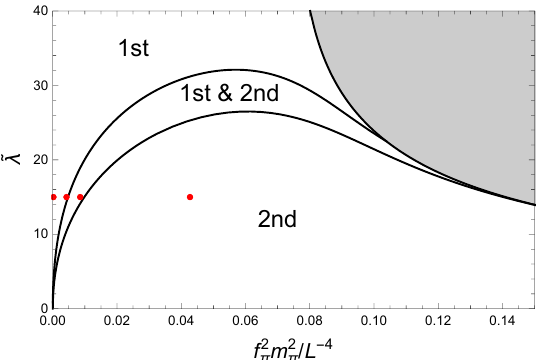
Figure 7 . Di(cid:11)erent topologies of the phase diagrams in the plane of rescaled ’t Hooft coupling ~ (cid:21) and quark mass parameter, classi(cid:12)ed according to the mesonic-LTQ transition, which can be discontinuous everywhere ("1st"), discontinuous at small temperatures and continuous at large temperatures ("1st & 2nd") or continuous everywhere ("2nd"). The shaded area is excluded since our approximation breaks down. The 4 (red) dots mark the parameter pairs chosen for the phase diagrams in (cid:12)gure 6. The translation from the mass parameter ~ (cid:11) to the more physical